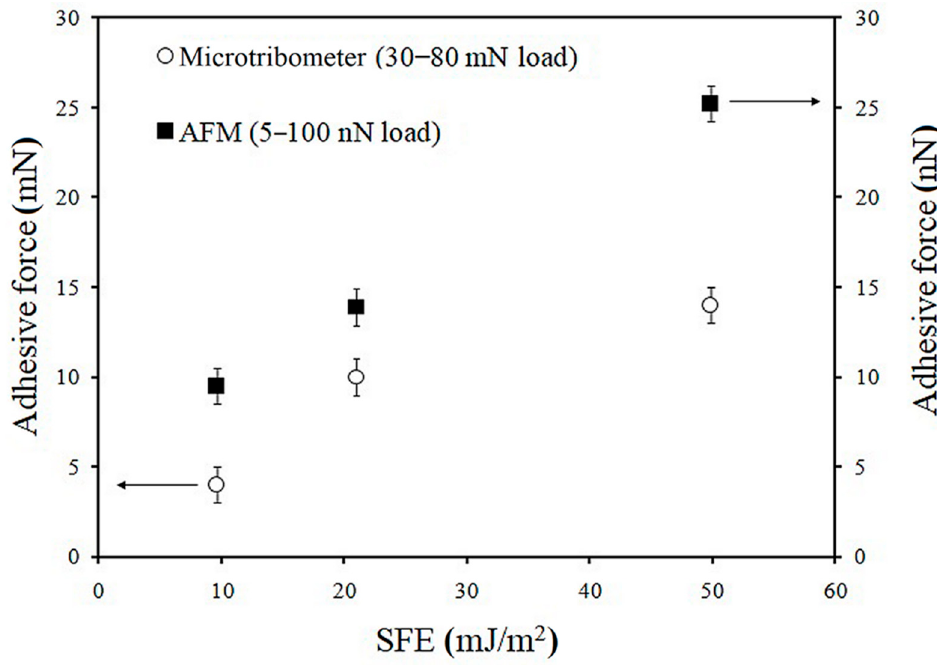
Figure 8. Adhesion force obtained for millinewton (microtribometer) and nanonewton (AFM) loads during tribological tests as a function of the SFE of investigated surfaces.